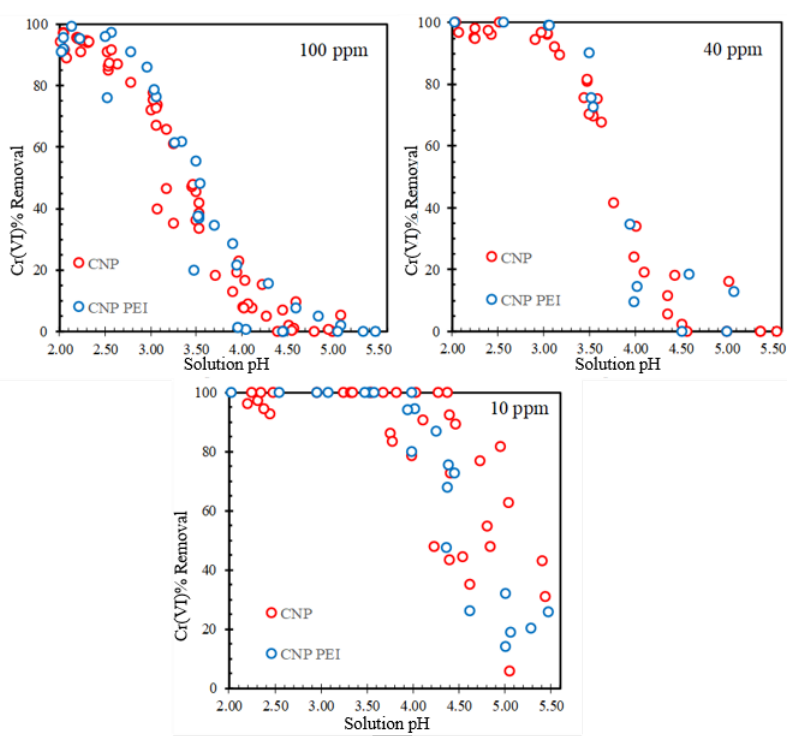
Figure 1. Removal efficiencies of CNP and CNP PEI carbons in the pH range of 2 to 5 at the concentration of Cr (VI) of 10 mg/L, 40 mg/L and 100 mg/L. Table 1. pH of the carbon surface and isotherm parameters for Cr (VI) adsorption on CNP and CNP PEI at solution pH of ~ 2.